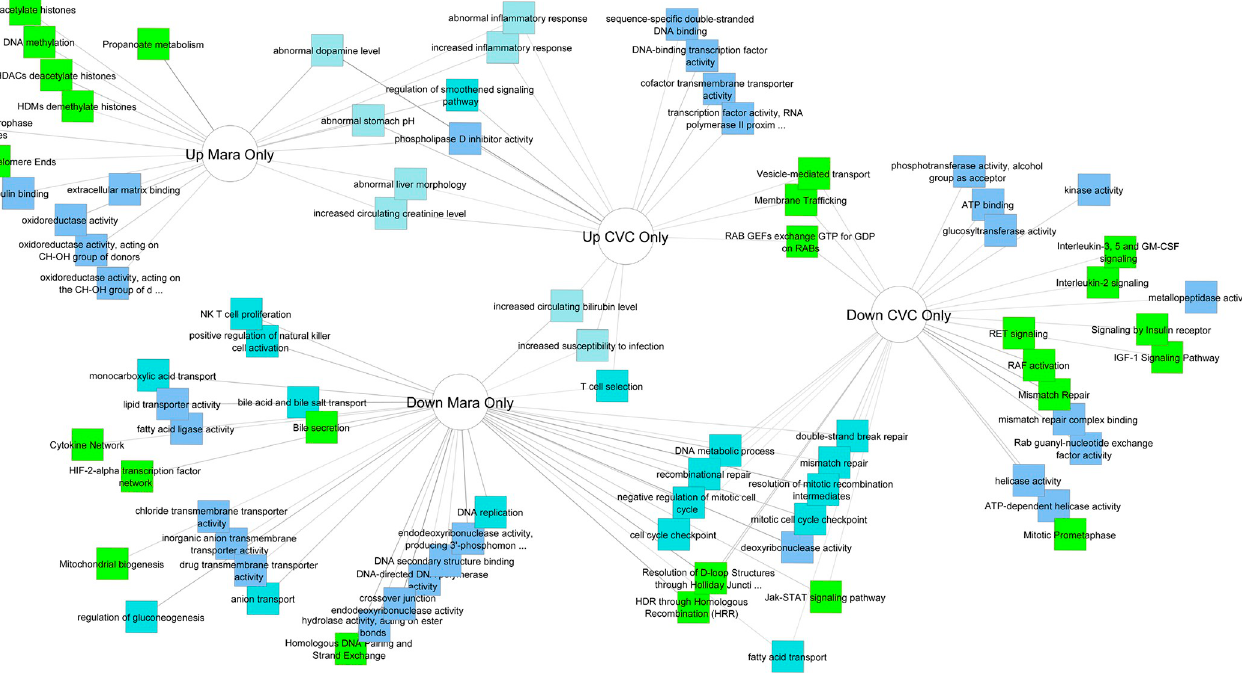
PLOS ONE | https://doi.org/10.1371/journal.pone.0224523 October 29,